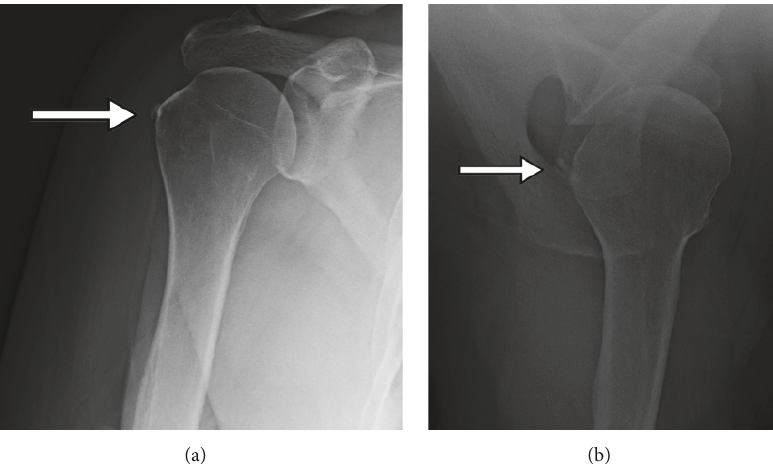
Figure 1: Radiographs with no distinct bone lesions noted. However, subtle decrease in trabecular bone density adjacent to the greater tuberosity is noted in (a) near the arrow tip. The arrows also indicate mild calcific tendinitis.